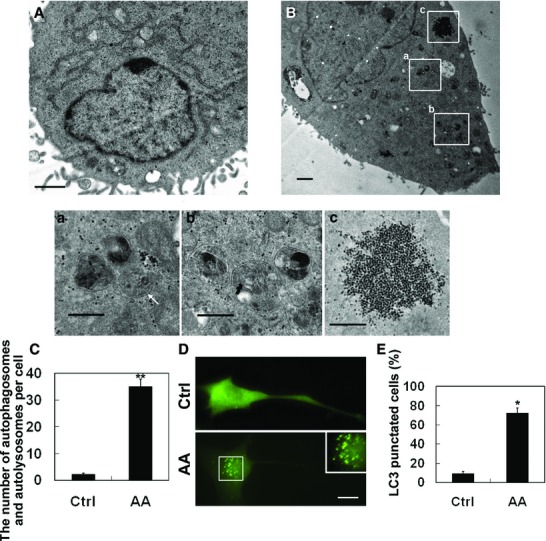
Aurantiamide acetate-induced autophagosome and autolysosome accumulation in U87 cells. Normal healthy U87 cells (A) or cells following 48-hrs of 25 μM aurantiamide acetate incubation (B) were fixed. The ultrastructure alternations were observed under TEM. Boxed areas in (B) were enlarged in (a–c). (a) The de novo formation of double membrane-bound phagophore was indicated by arrow. (b) Autophagosomes engulfed with material to be degraded. (c) Glycogen particles. Scale bars in (A) and (B), 1 μm; scale bars in (a–c), 0.5 μm. (C) The number of autophagosomes and autolysosomes per cell was calculated from 12 micrographs. (D and E) U87 cells were transfected with GFP-LC3 plasmid. Following 48-hrs of 25 μM AA incubation, the fluorescence was examined under fluorescent microscope. Inset shows enlarged image of boxed region. (E) The percentage of LC3 punctated cells was calculated from 12 micrographs. *P < 0.05; **P < 0.01 compared with control.